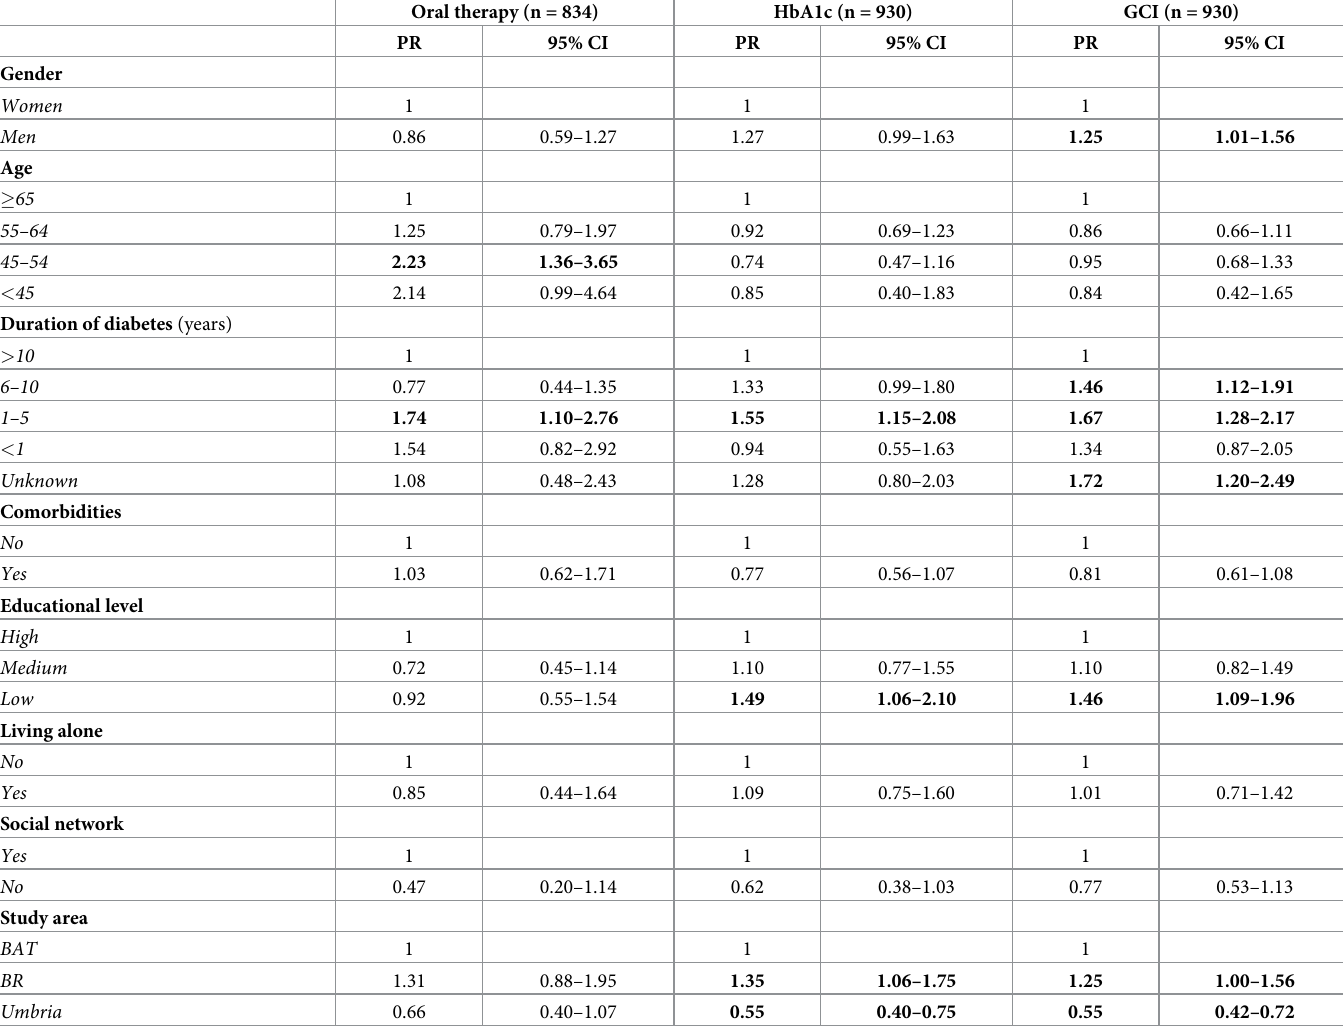
Table 3. Individual characteristics associated to non-adherence to prescribed oral therapy and recommended clinical